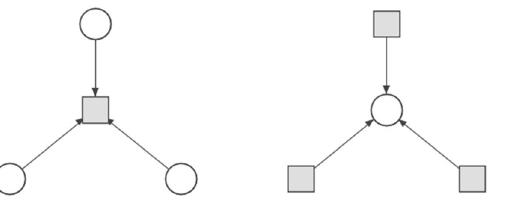
Figure 7. Two variants of digraphlet G